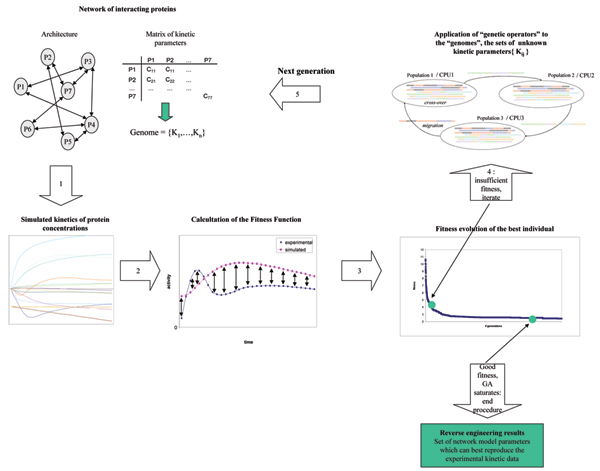
Genetic algoritm scheme. Flow chart of the estimate procedure using the genetic algorithm (GA). Every unknown model parameter is called a " gene", while the whole set of parameters to be estimated is defined as the " genome". Every genome is contained within an " individual", the computational entity able to " evolve". An ensemble of genomes corresponds to a "population". The GA procedure begins with an initial random guess of the parameters values used to run a simulation of the model network. This first step is iterated for all the individuals belonging to different populations. For each individual, the simulated time course of the concentrations for specific proteins are compared with the experimental measures and the distances between the functions are calculated. Every individual is thus related to a fitness index, measuring the degree of compatibility of the genome with the experimental constraints. A small number of individuals are selected based on their fitness but also on probabilistic rules: they will have the genomes randomly mutated by genetic operators, giving birth to a new offspring that enters the next generation. At each round the plot describing the evolution of the best fitness computed until then is updated: when it clearly saturates the algorithm stops and the genome corresponding to that fitness is the solution of the algorithm.